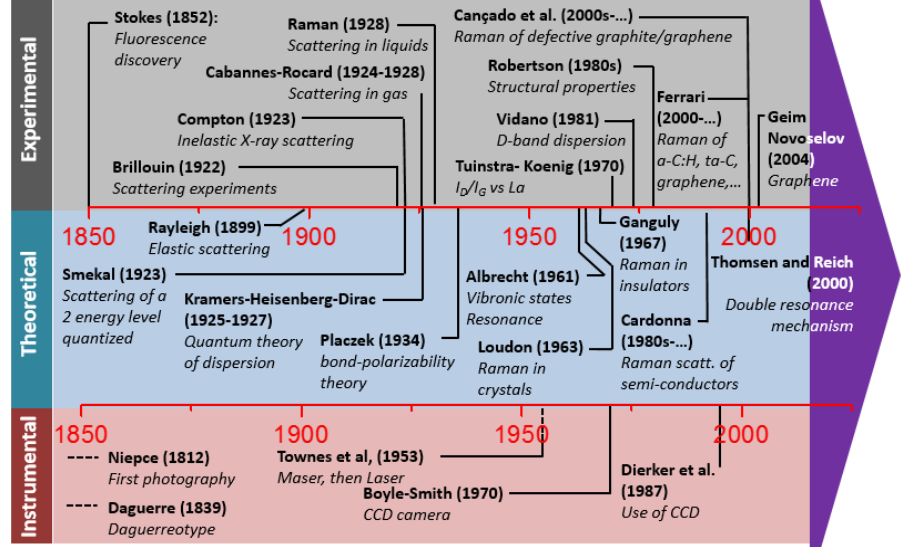
Figure 1. Quick chronology of the Raman effect.